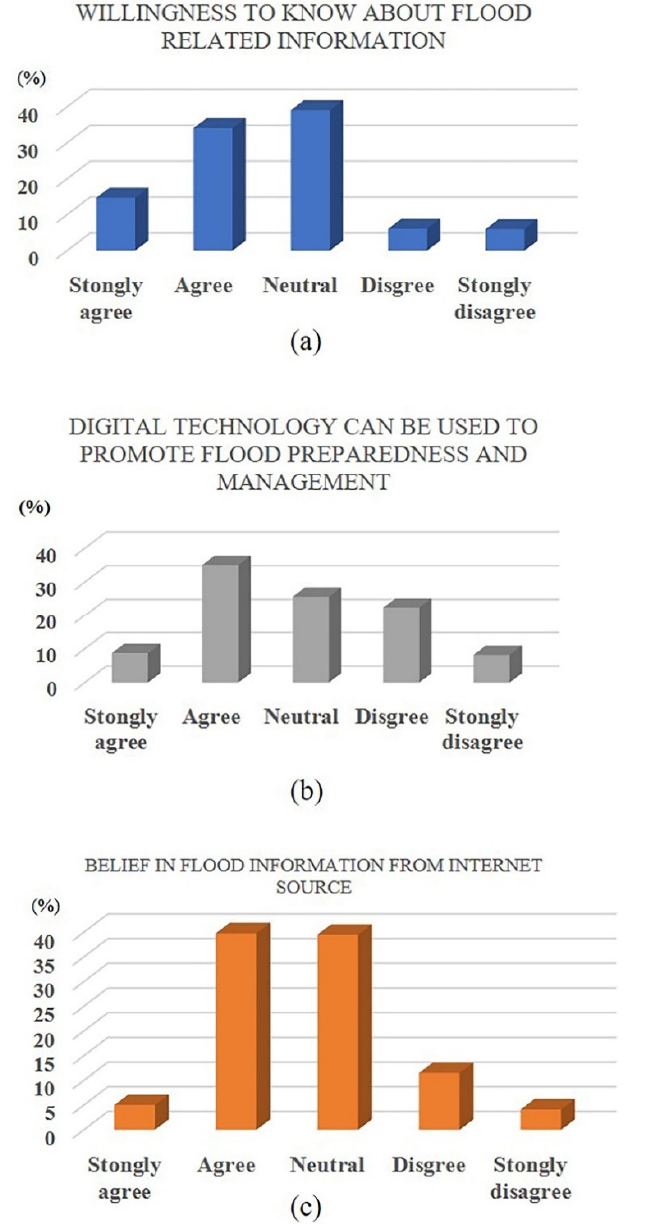
Figure 5. ( a ) Willingness to know about flood information of the elderly respondents, ( b ) their per- ception of digital technology influences flood preparedness, and ( c ) belief in flood-related infor- mation from internet sources (n =